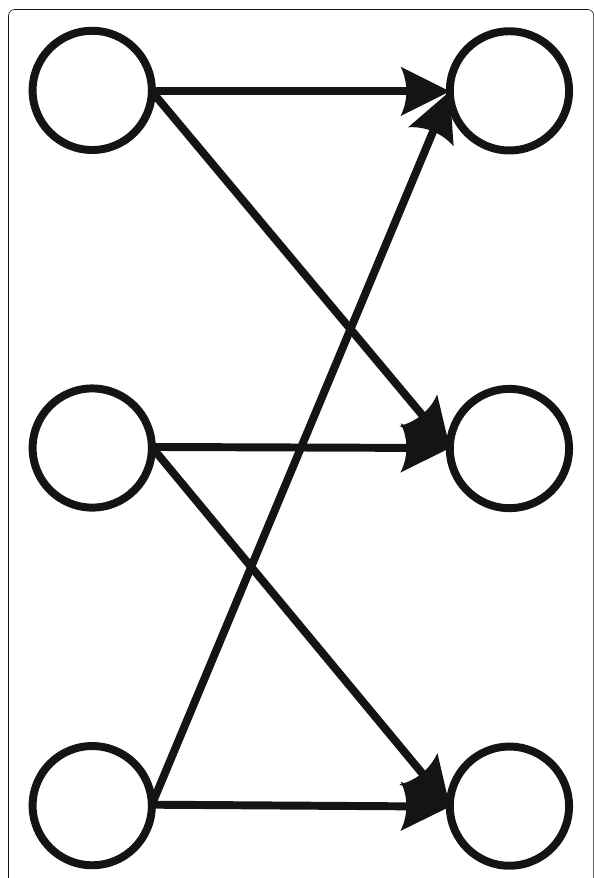
Fig. 12 The only connectivity that results in a per layer fully connected conflict graph in a 3 × 3 × 3 network with d max =